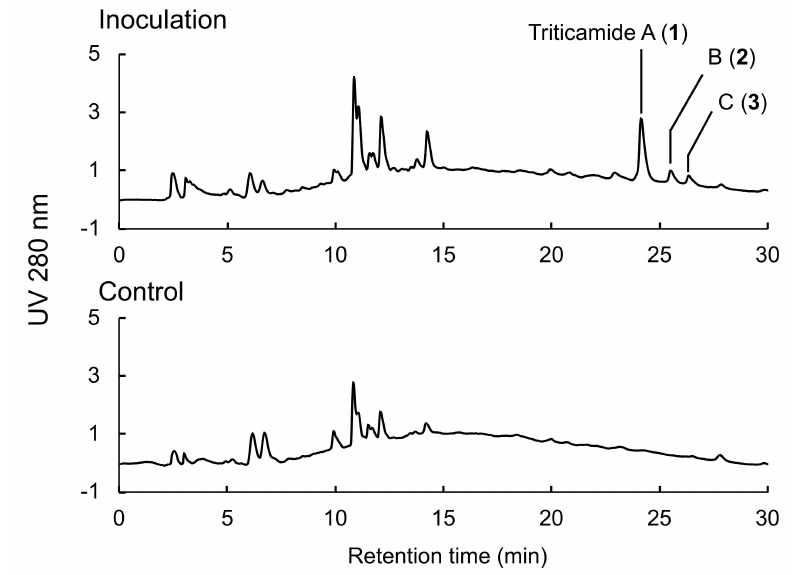
Figure 1. High-performance liquid chromatography (HPLC) analysis of extracts from Fusarium culmorum -infected and control roots. Agar plugs of F. culmorum -inoculated and control V8 medium were placed on the roots of 4-d-old barley seedlings, and extraction was performed at 72 h after